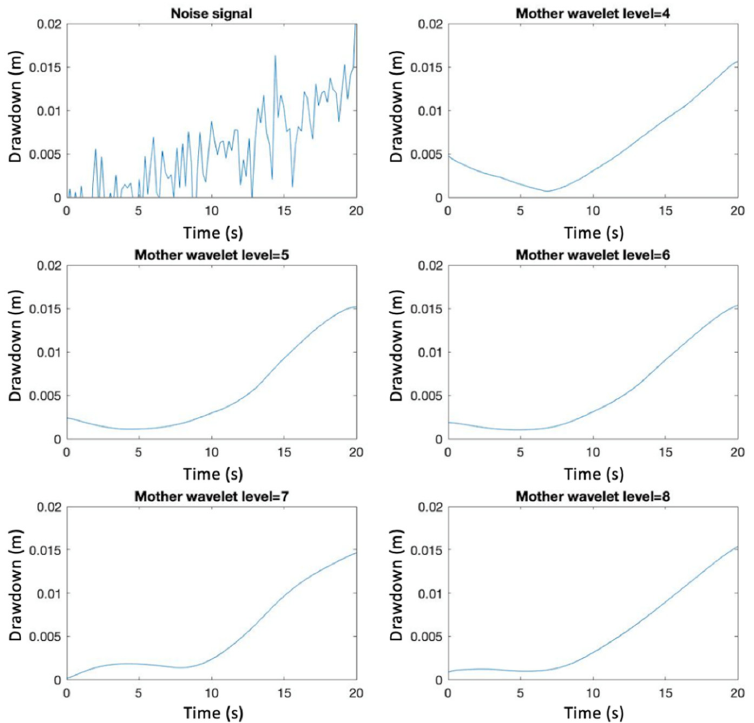
Figure 13. The beginning part of “Symlets” mother wavelet de-noising results with different mother wavelet levels.